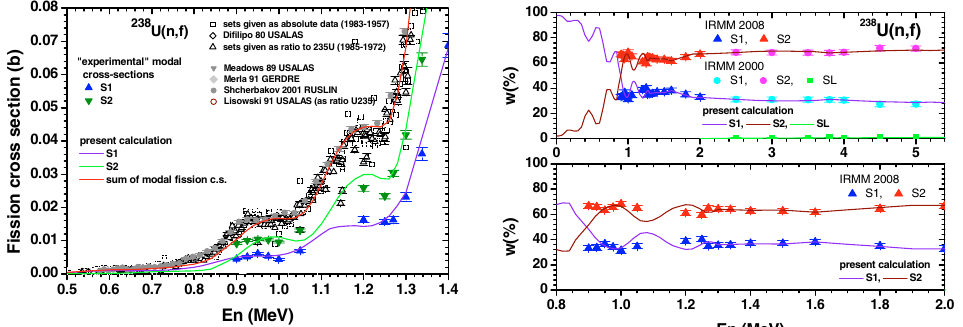
Fig. 2. Left part: New fission cross section calculation for the S1 and S2 modes as well as their sum (full lines) in comparison with the experimental data in the vicinity of the vibrational sub-barrier resonances.